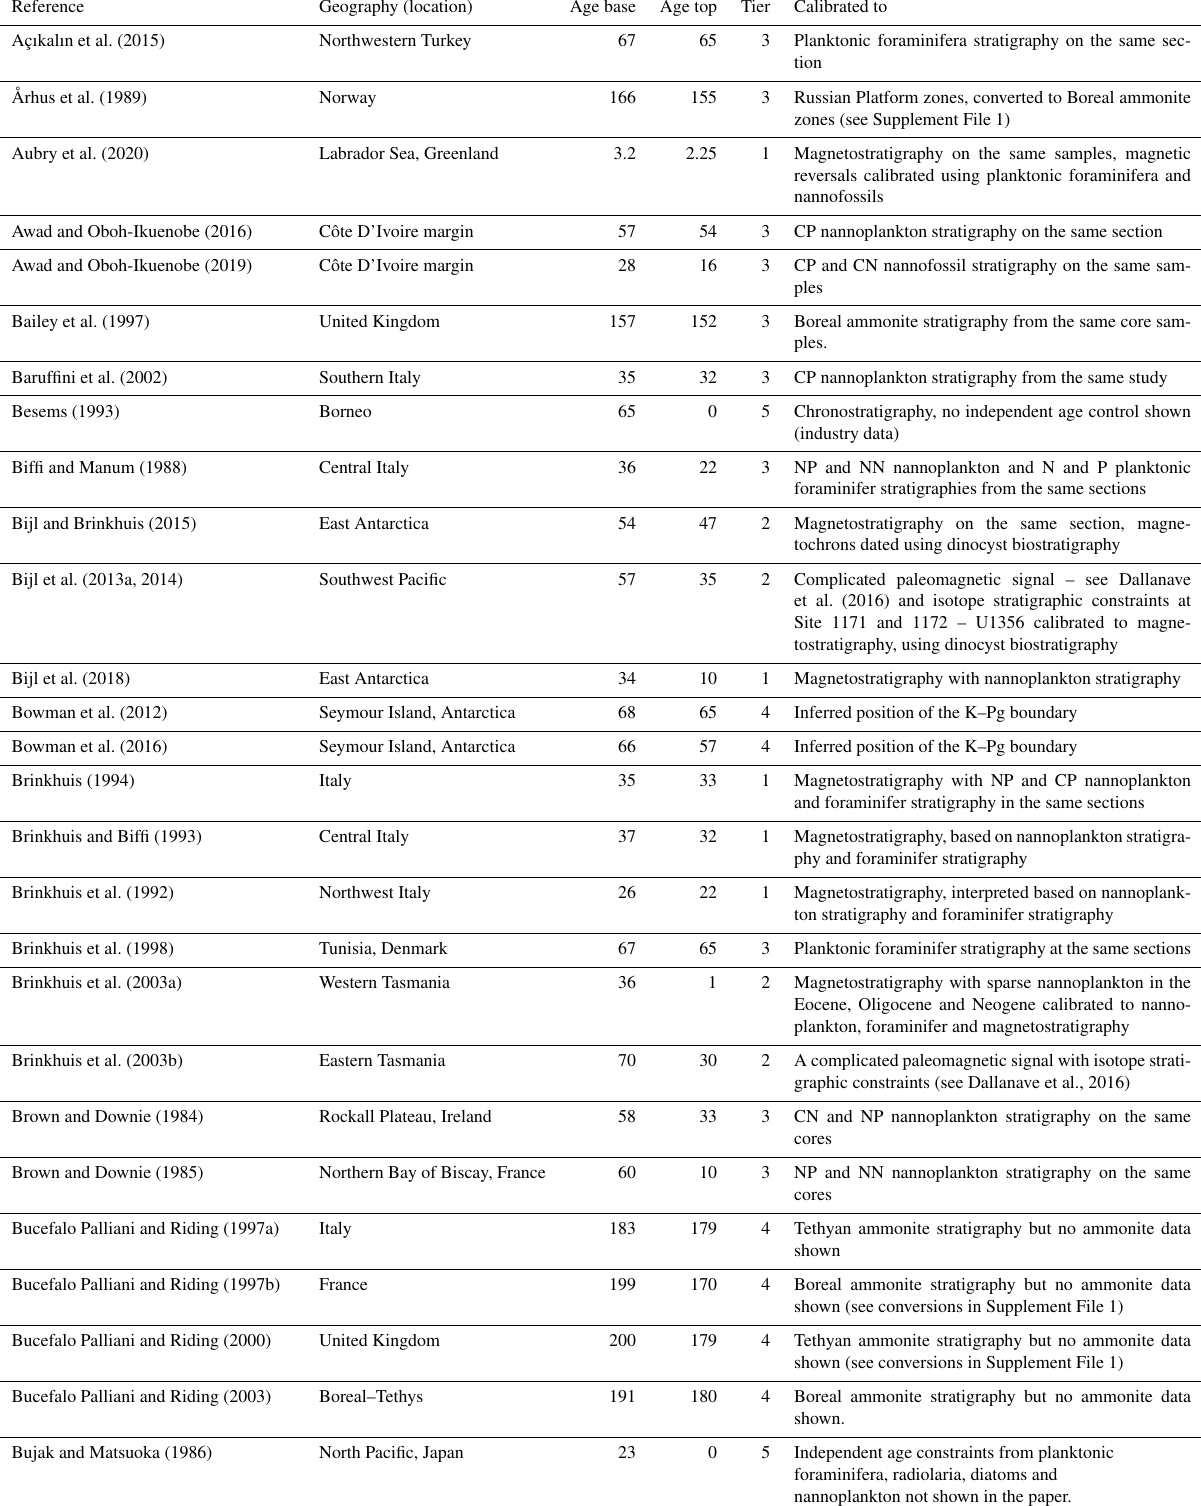
Table 1. Papers used in this review. Reference, geography, age base and age top (in Ma), tier (see Fig. 1), and means of calibration to the geologic time scale (GTS). The abbreviations of the microplankton zones indicated in the column “Calibrated to” (NJ, NC, NP, NN, CC, CP, CN, UC, N, P, E) are those commonly used in the literature and relate to the zones presented in the GTS2012 (Gradstein et al.,